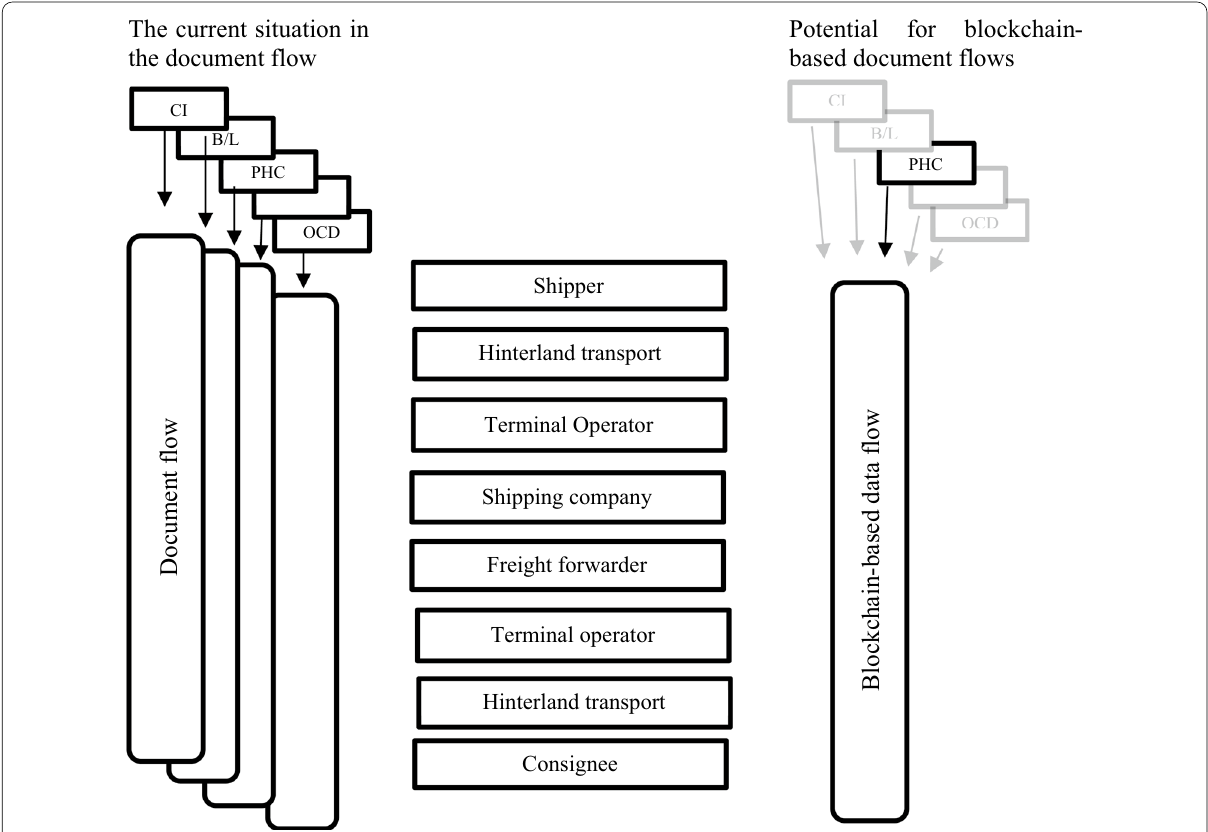
Fig. 2 Potential for introducing blockchain-based document flows. Source : own